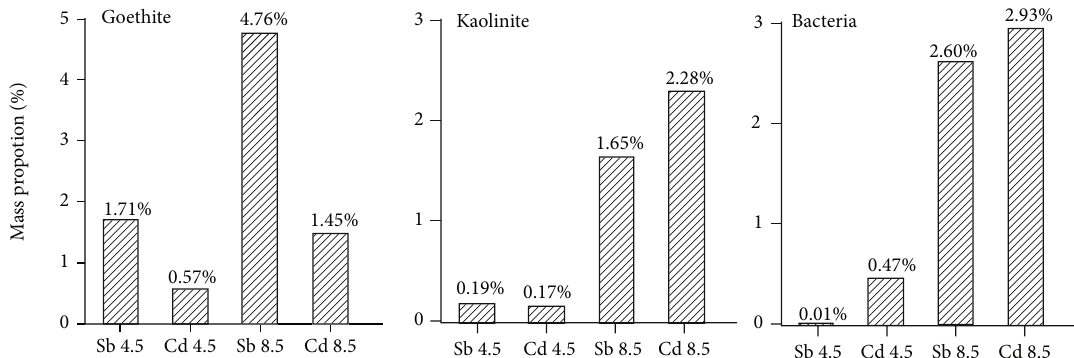
Figure 3: Mass percentage of Cd(II) and Sb(V) in goethite, kaolinite, and Bacillus cereus cell. Data are produced from Figure